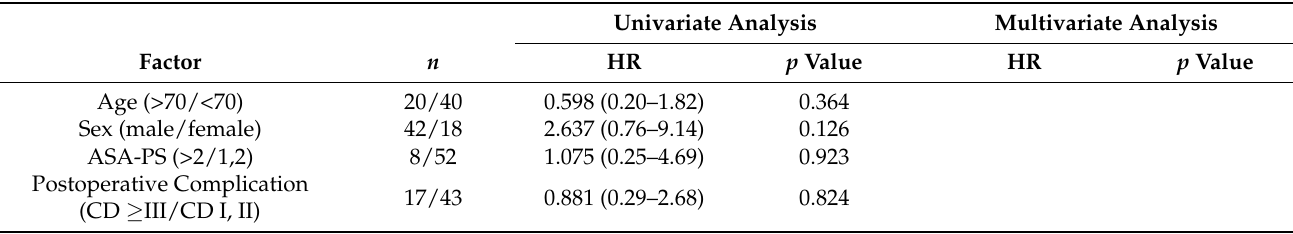
Table 5. Univariate and multivariate analyses for relapse-free